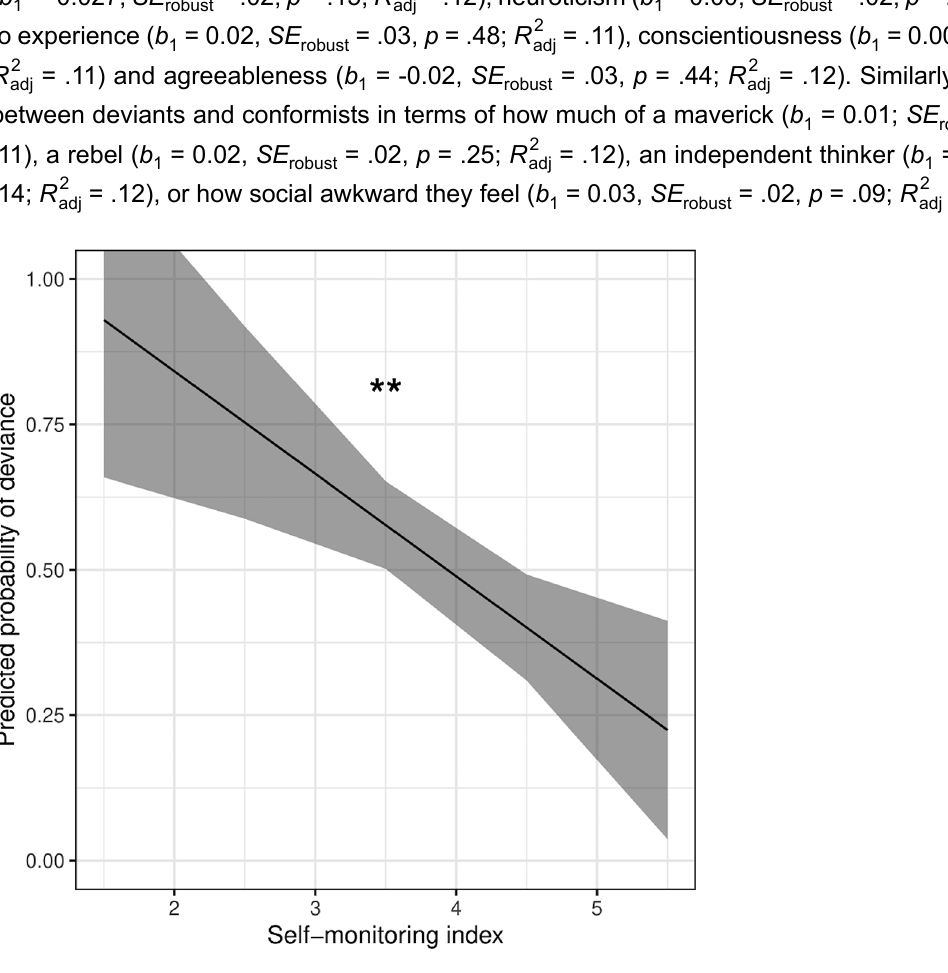
Figure 6. Predicted probability of deviance based on separate regressions of the binary deviance indicator on the self-monitoring index, controlling for demographic variables set at their